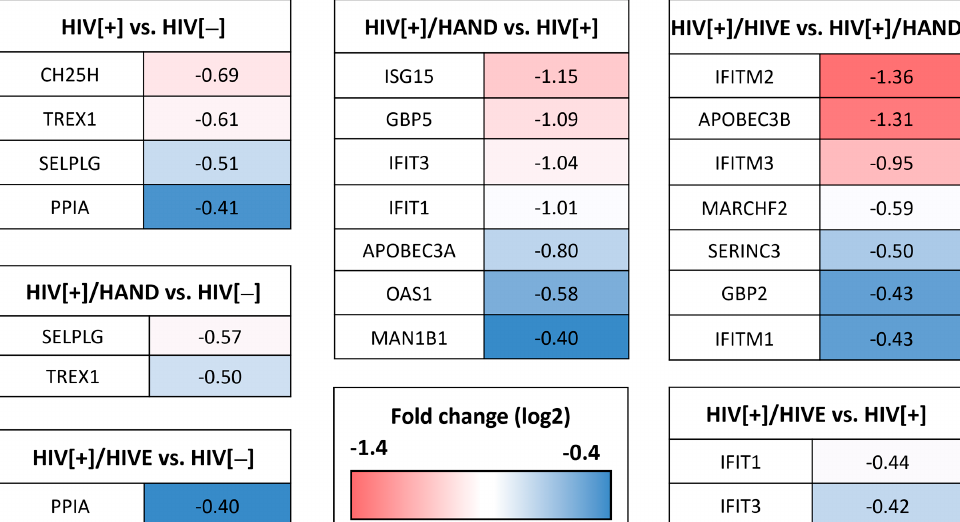
Viruses 2023 , 15 , 316